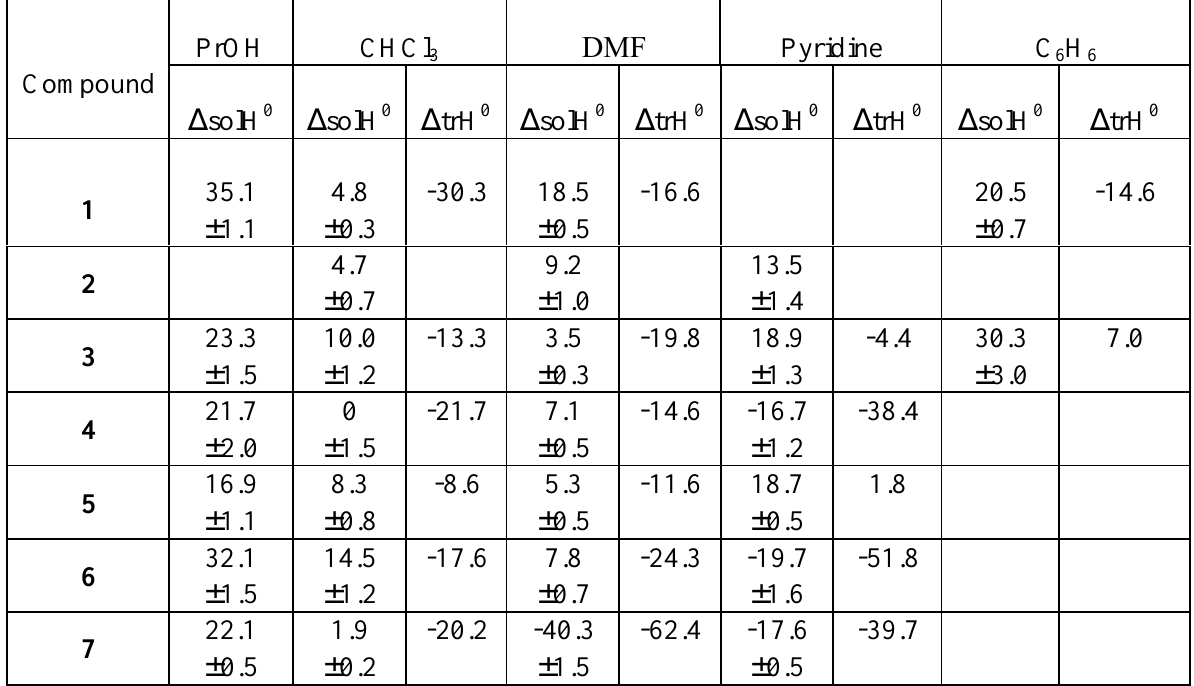
Table 3. Standard changes of dissolution enthalpies ( D sol.H 0 ) and transition enthalpies ( D tr.H 0 )